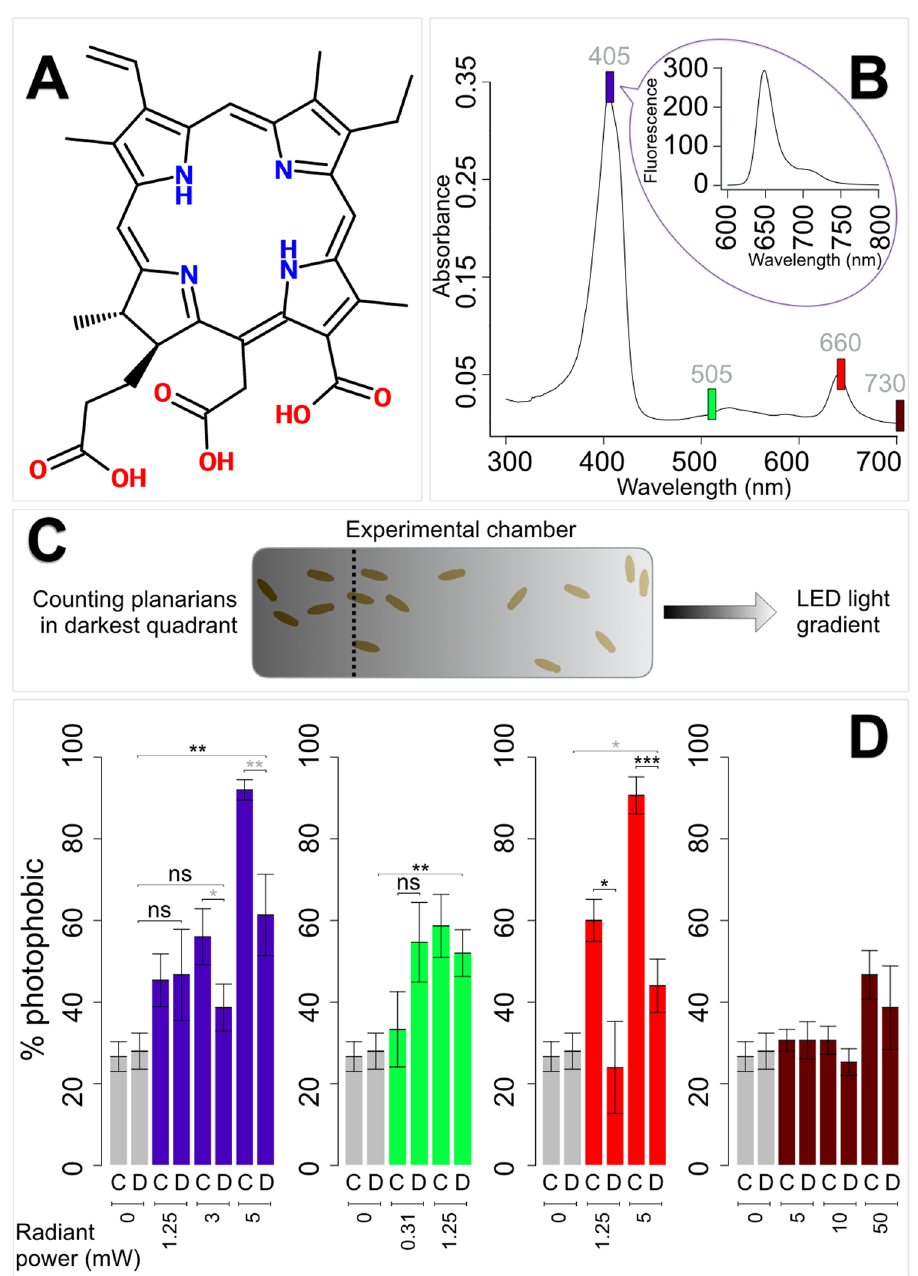
Figure 1. Chlorin e 6 enhances UV and red-light avoidance in Dugesia japonica . ( A ) Skeletal formula of chlorin e 6 . ( B ) Absorption and emission (smaller graph, excitation wavelength ~405 nm) spectra of chlorin e 6 dissolved in 1% v/v dimethyl sulfoxide; colored boxes approximate wavelength positions (exact values in gray, nm) for the tested colors (left to right: UV, cyan, red, NIR). ( C ) Representation of the experimental chamber used for behavioral experiments, with LED light diffusing from the right edge; animals found within the darkest quadrant (area delimited by the vertical dashed line) after two minutes of light exposure were counted as photophobic. ( D ) Bar charts reporting the percentage of photophobic animals, either treated with chlorin e 6 ( C ) or plain dimethyl sulfoxide ( D ), after exposure to light of different wavelengths (charts from left to right: UV, cyan, red, NIR) at different radiant power. Grey bars illustrate control experiments with no light stimulus provided. Grey asterisks indicate significance for unpaired one-tailed T-test; black asterisks indicate significance for unpaired one-tailed T-test and two-tailed Mann Whitney U-test. The number of asterisks specifies significance for different p-value threshold of the unpaired one-tailed T-test ( * for p < 0.05, ** for p < 0.01, *** for p < 0.001); such threshold, for the two-tailed Mann Whitney U-test, is invariably p < 0.05. n = 5, 15 specimens per experiment, 75 animals per class; error bars report standard error of the